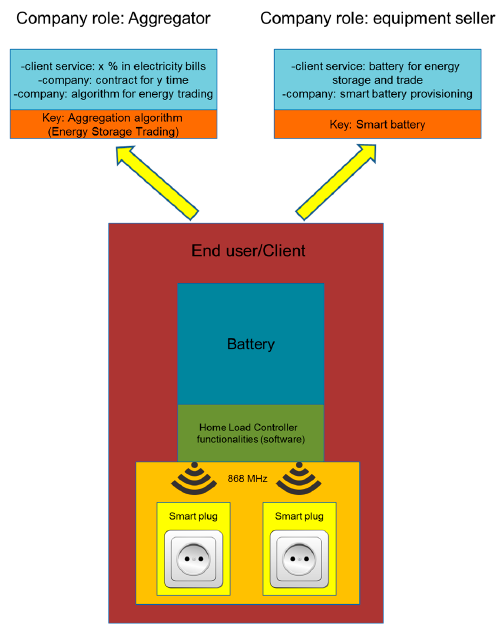
Figure 2. Third party possible roles in the business proposals. Table 2. Business models proposition and